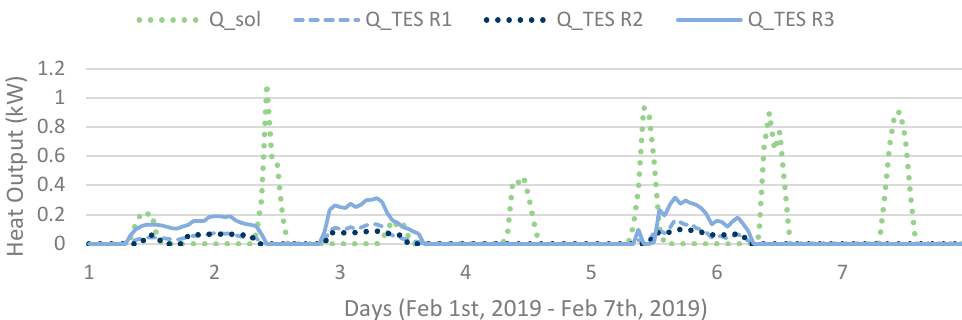
Figure 12. Hourly heat output (in Sim4) of each operating unit (R1, R2, R3) and obtained heat of the solar collectors for a week.